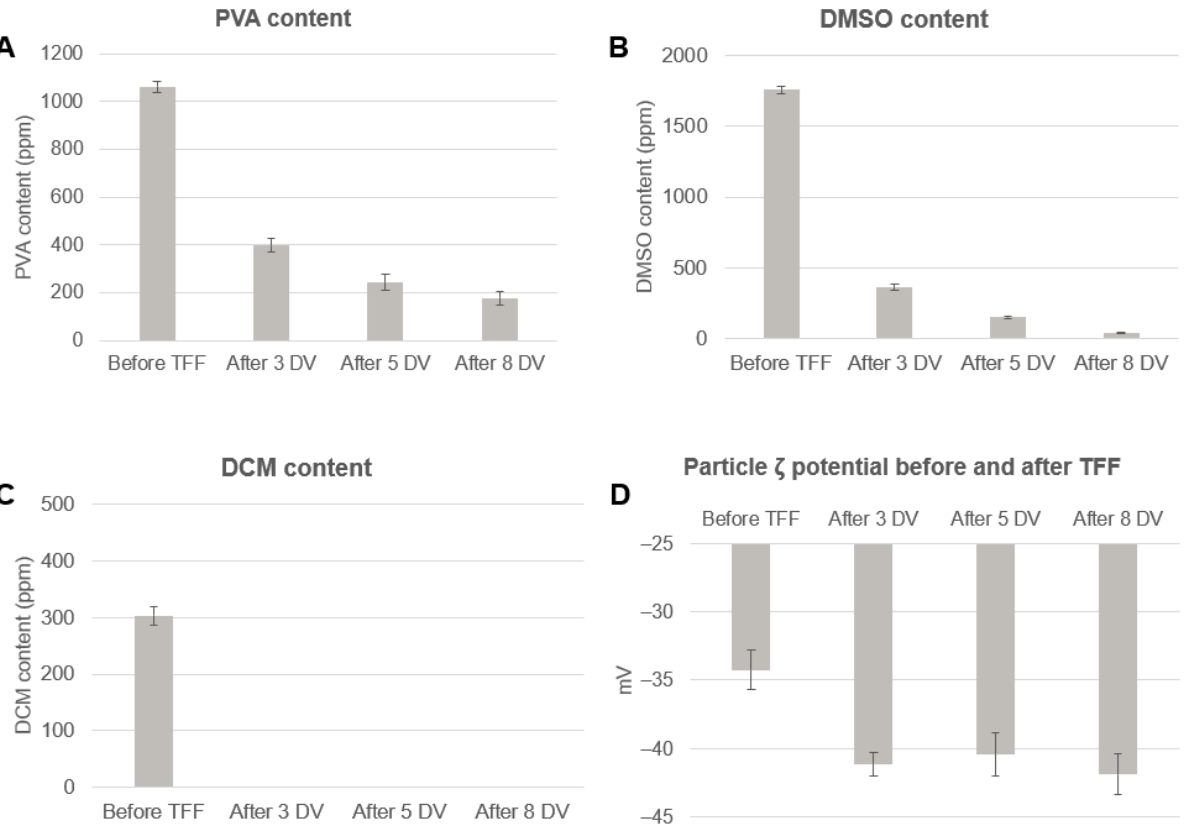
Figure 4. Downstream process evaluation. Reduction in ( A ) PVA, ( B ) DMSO, and ( C ) DCM content and ( D ) particle zeta potential tested before and after 3, 5, and 8 DVs. Table 5. Impact of different TFF diafiltration volumes in reducing PVA, DMSO, and DCM content.